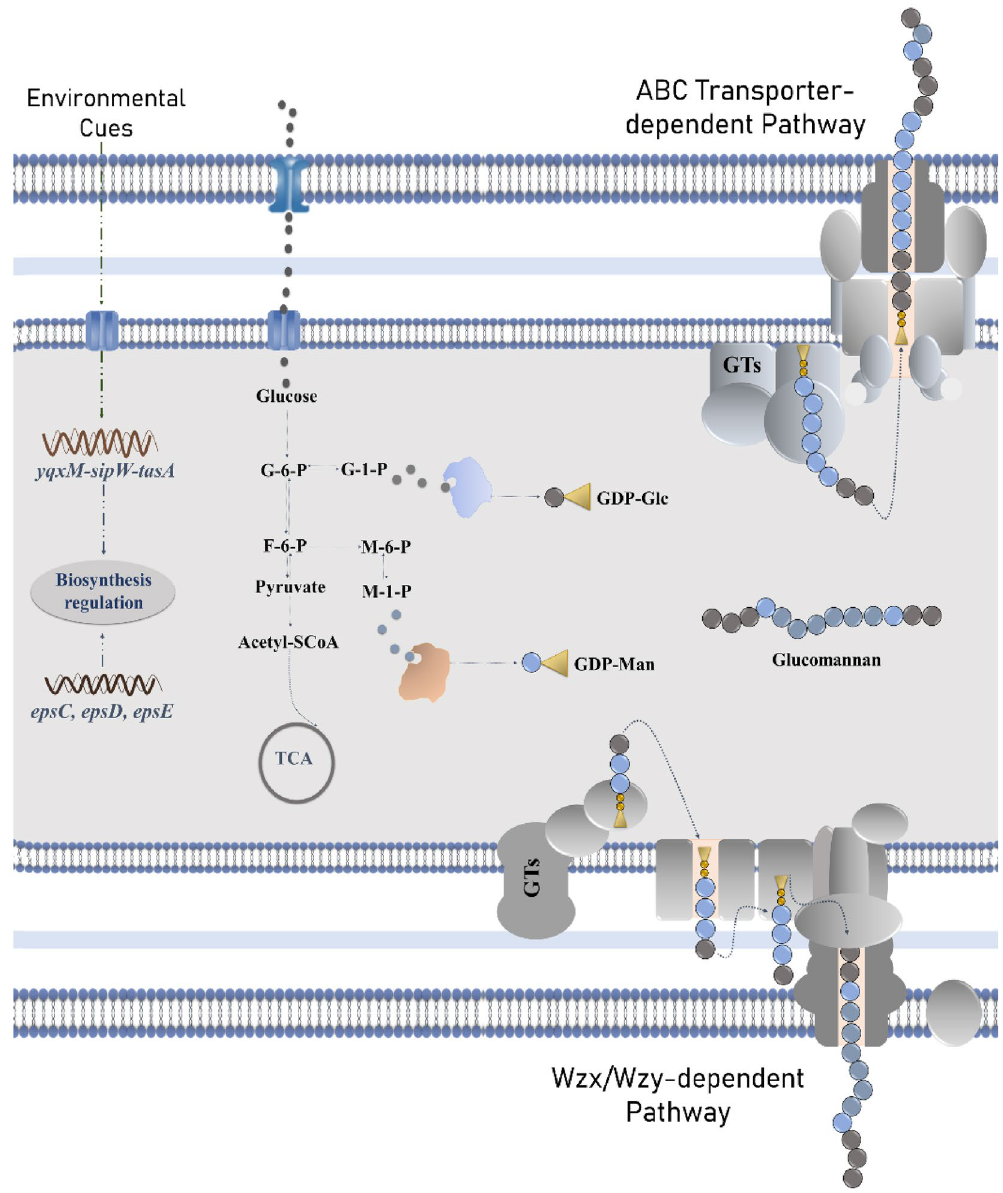
Figure 8. Schematic representation of probable EPS biosynthesis pathway based on the predicted coding genes from the genome of strain